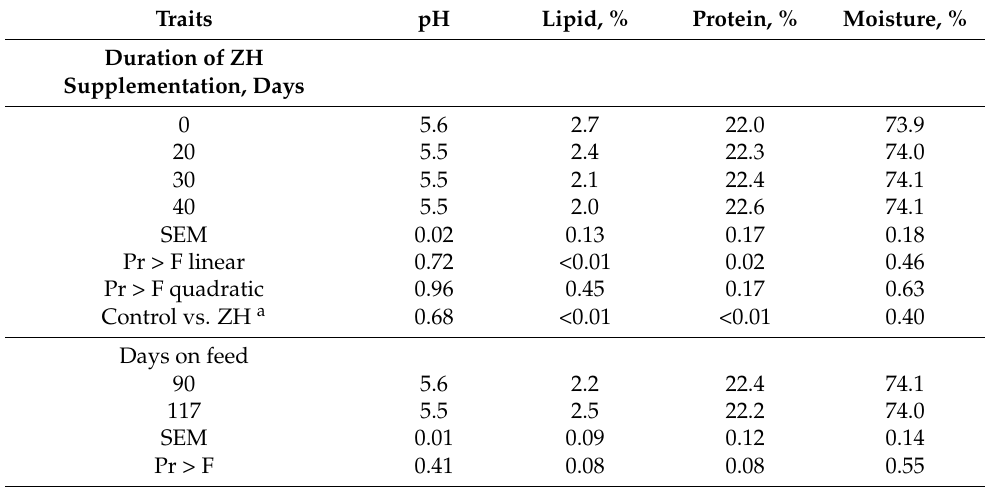
Table 2. Least square means, standard error of the mean (SEM), and probabilities (Pr > F) of pH and chemical composition of meat samples according to the duration of zilpaterol hydrochloride (ZH) supplementation and days on feed.